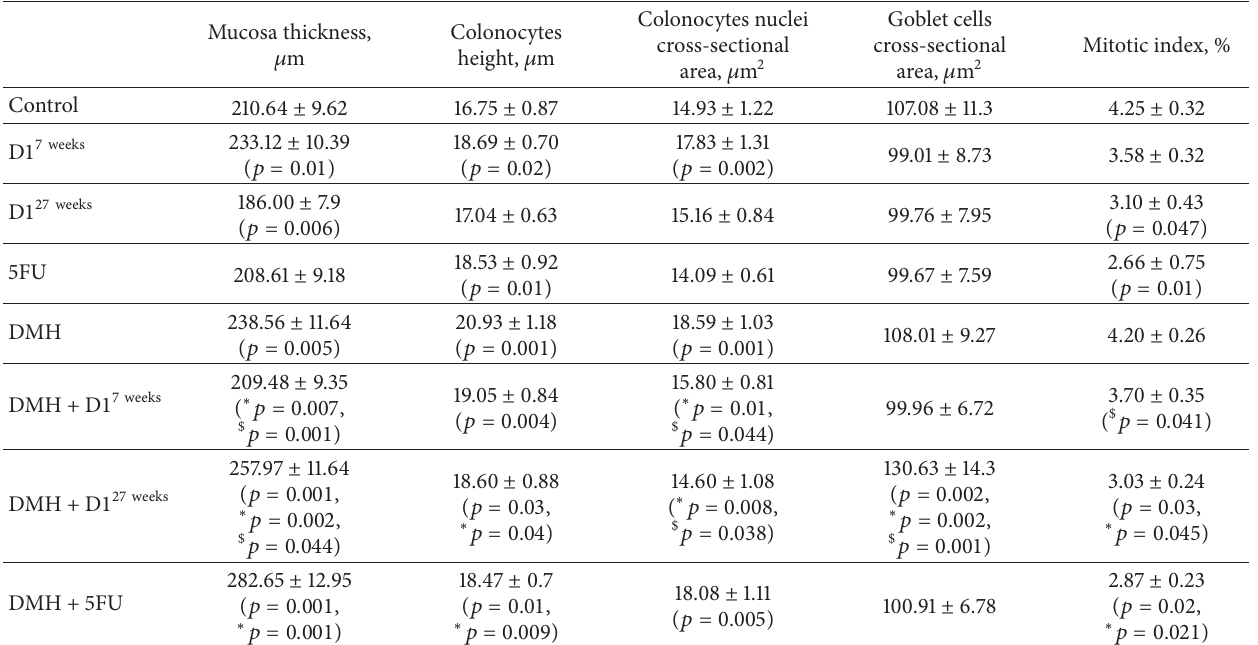
Table 2: Morphometric parameters of colon mucosa, adjacent to colonic tumors for rats treated by D1 and 5FU under DMH-induced carcinogenesis. Mean ± SEM, 𝑛 = 10 #